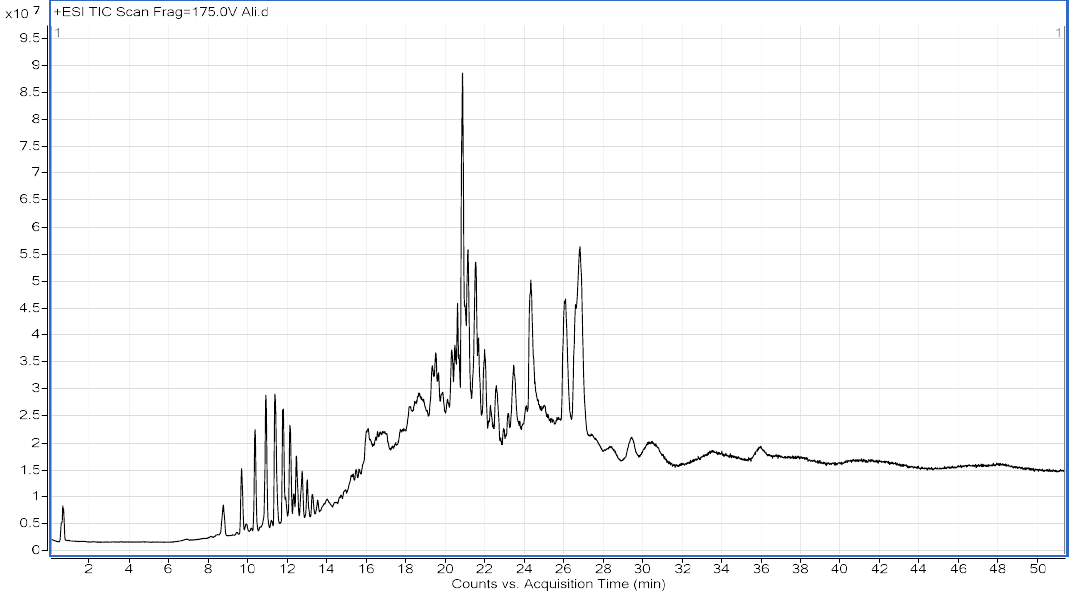
Figure 4. Chromatogram of the Ethanolic extract derived from freeze dried powder of PHF.